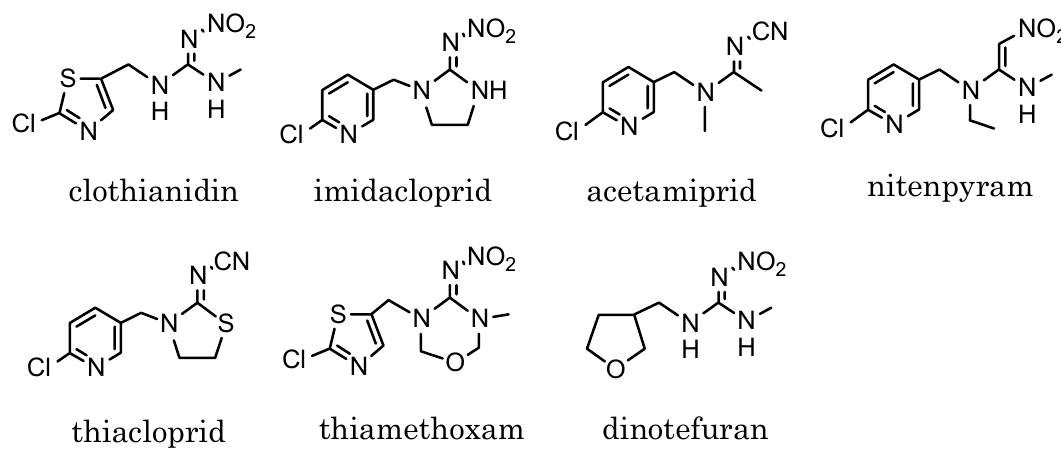
Figure 1. Structure of neonicotinoid